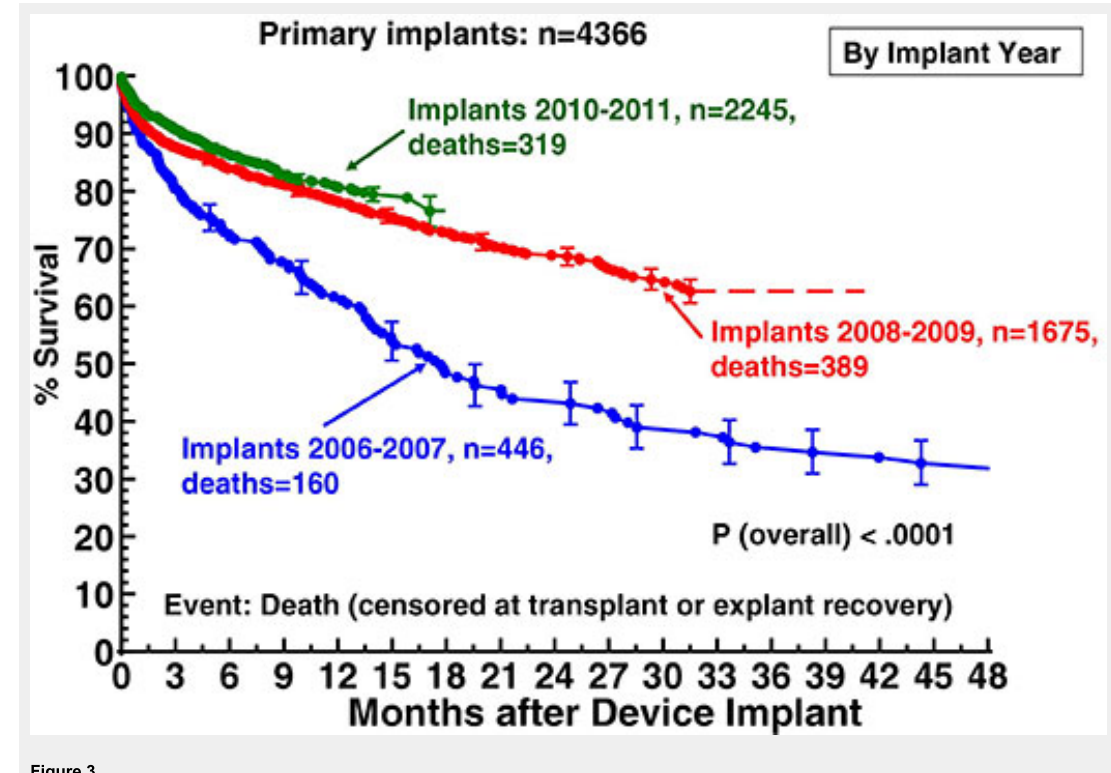
Figure 3 Actuarial survival following ventricular assist device implantation, stratified by era. © 2012 Elsevier. Kirklin JK, Naftel DC, Kormos RL, Stevenson LW, Pagani FD, Miller MA, et al. The Fourth INTERMACS Annual Report: 4,000 implants and counting. J Heart Lung Transplant 2012;31:117–26 [13]. Reprinted with kind